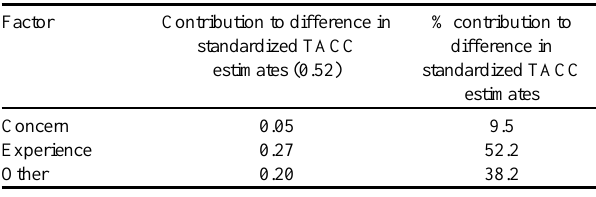
Table 6 . Decomposition analysis of the difference between values suggested for the total allowable commercial catch (TACC) by divers and owners. Note that “other” represents that portion of the difference that is unaccounted for by the model, i.e., unaccounted for by these variables. The mean difference is 0.52 (based on modeled